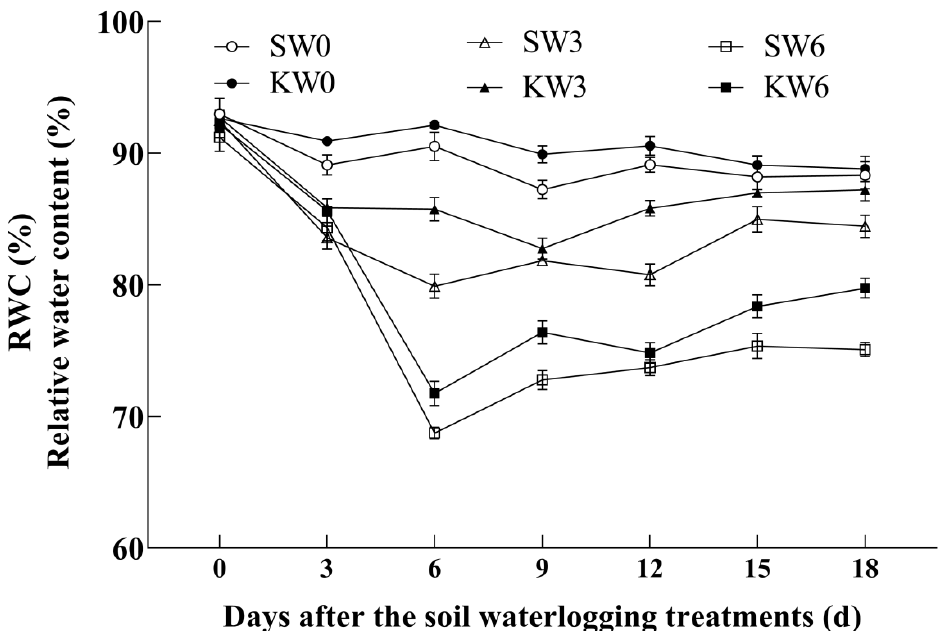
Figure 1. Effect of potassium application on leaf relative water content in cotton under soil waterlogging stress. The experiment treatments were SW0 (no potassium application and no soil waterlogging), SW3 (no potassium application and 3 d soil waterlogging), SW6 (no potassium application and 6 d soil waterlogging), KW0 (potassium application and no soil waterlogging), KW3 (potassium application and 3 d soil waterlogging) and KW6 (potassium application and 6 d soil waterlogging).